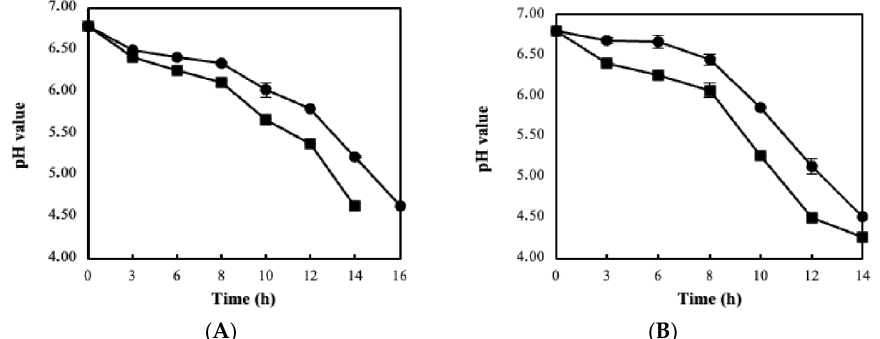
Figure 4. Milk acidification profile using free ( ● ) and immobilized biocatalysts on blended BC ( ■ ) of the strains L. pentosus B329 ( A ) and L. plantarum 820 ( B ).